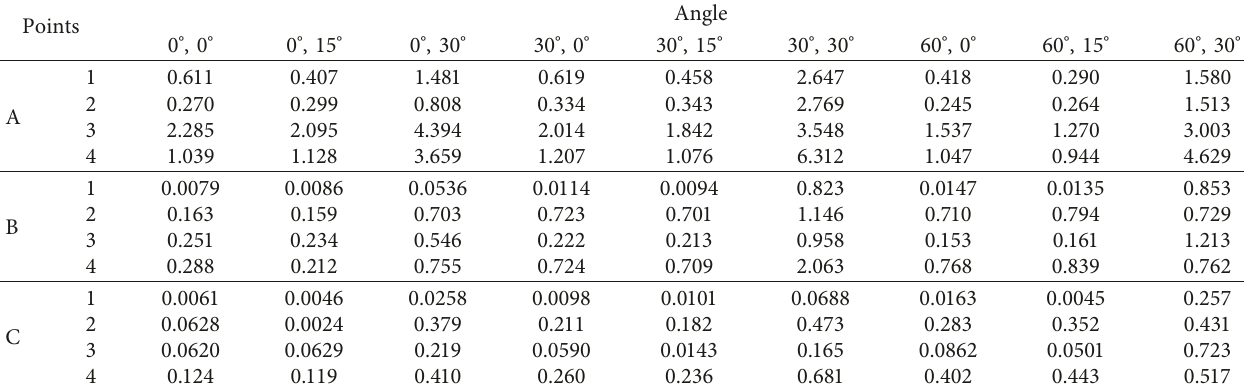
Table 4: Maximum principal stress (MPa).